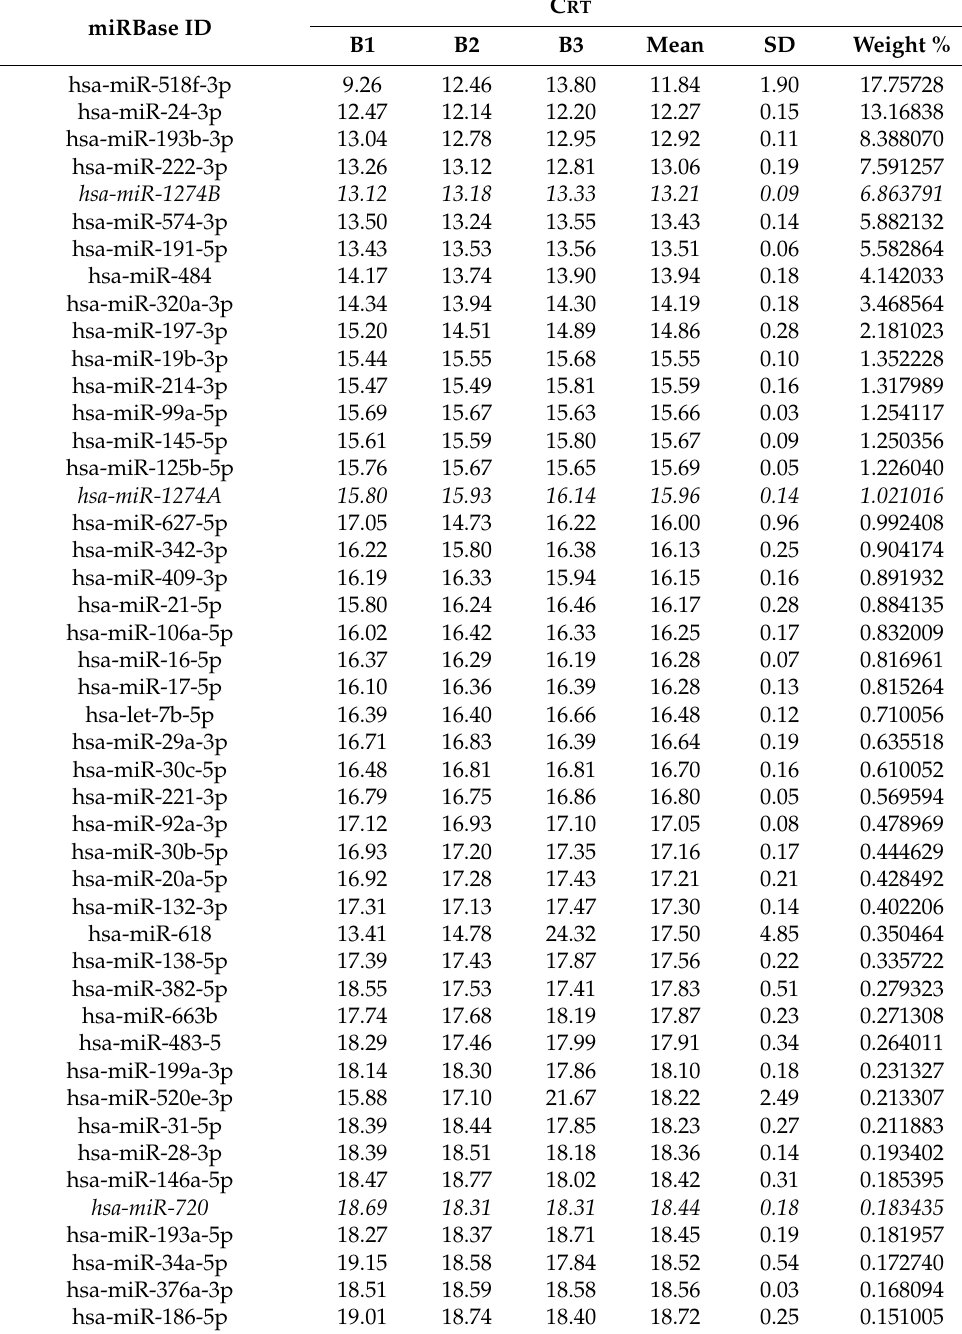
Table 3. miRNAs detected in SF-treated BMSC-EVs and falling in the first quartile of